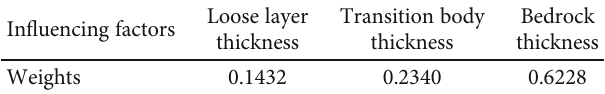
Figure 19: Fuzzy neural network training error curve. Table 6: Contribution weight of each in fl uence